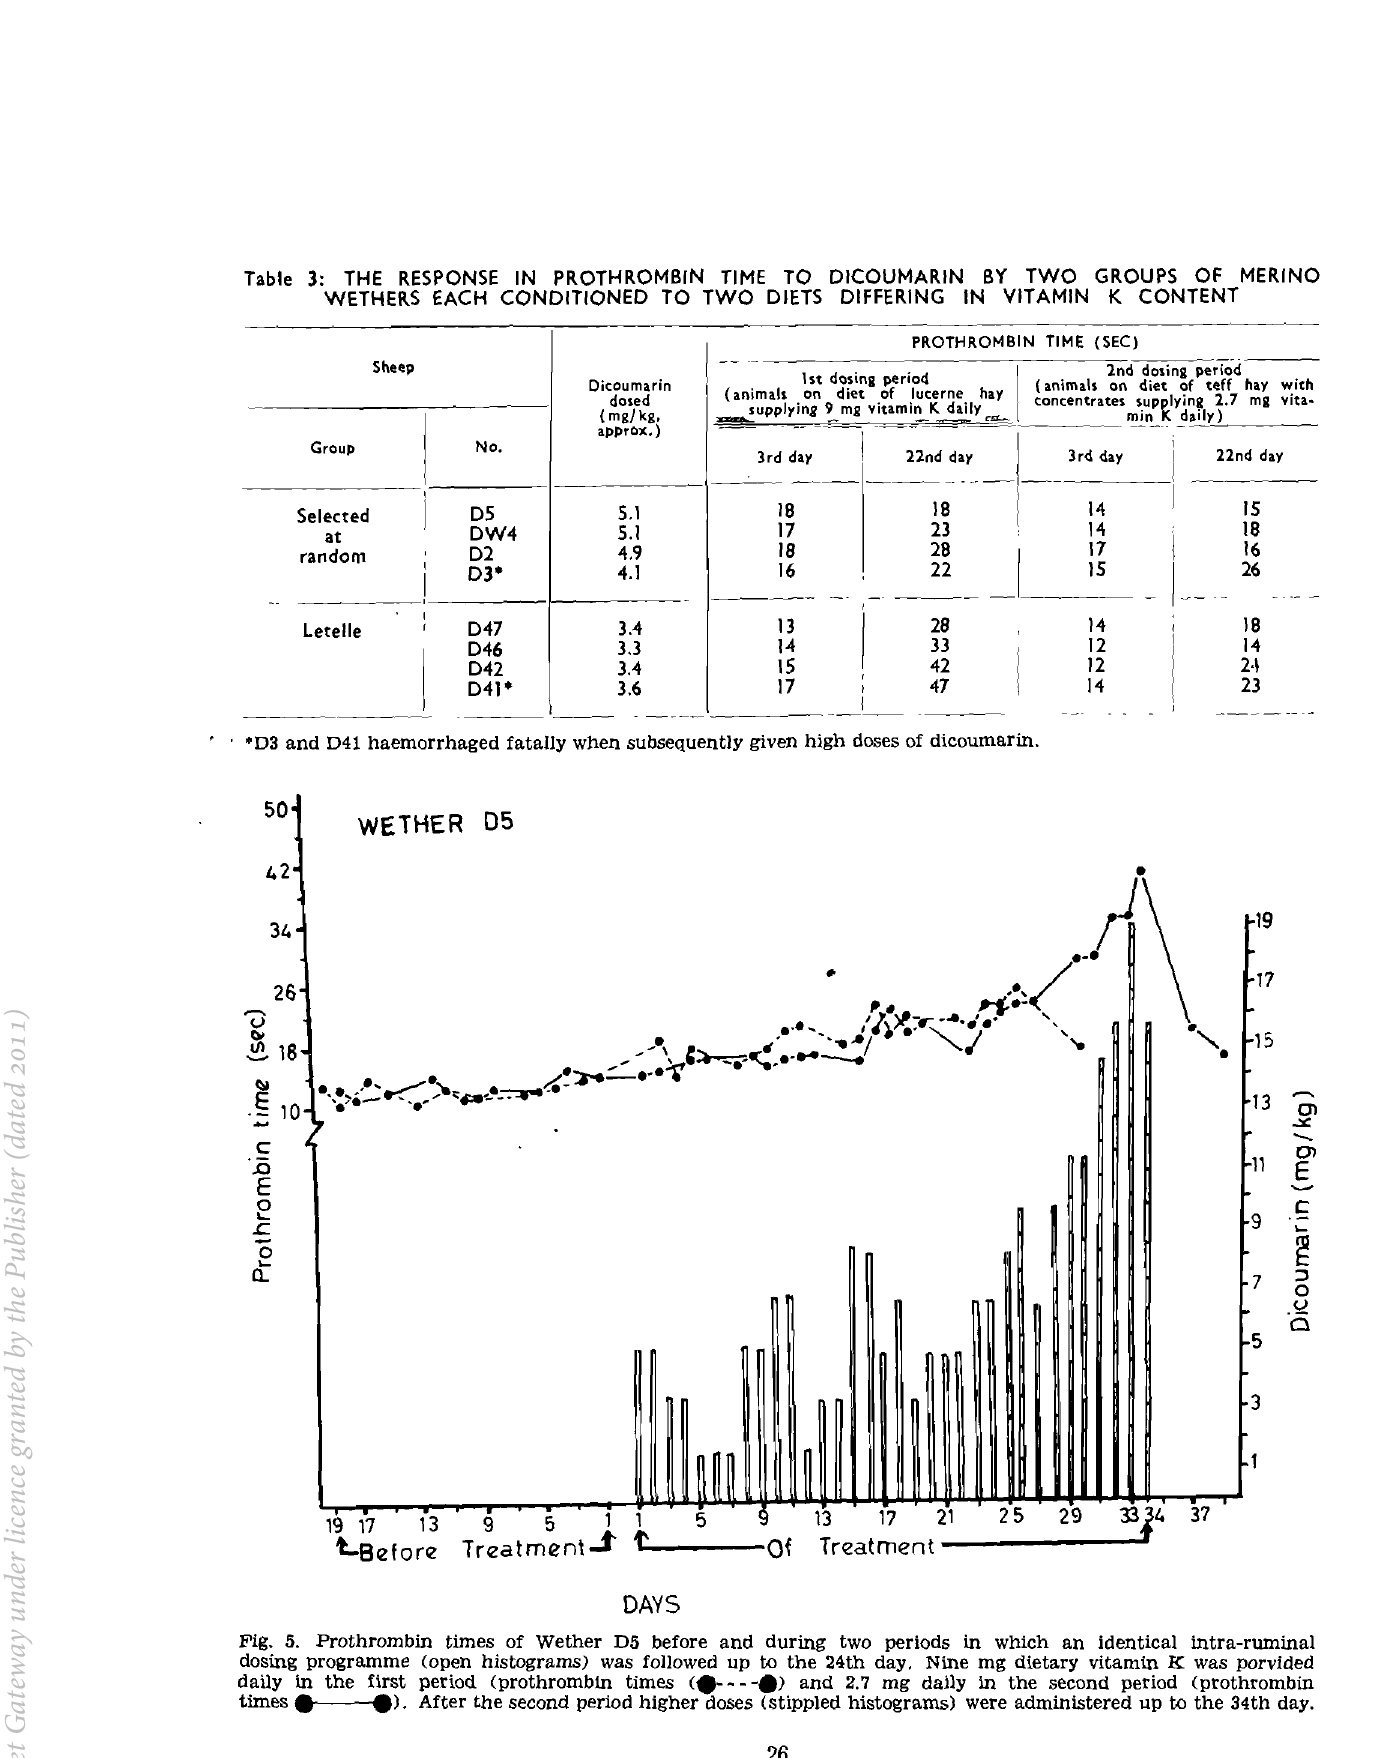
Table 3: THE RESPONSE IN PROTHROMBIN TIME TO DICOUMARIN BY TWO GROUPS OF MERINO WETHERS EACH CONDITIONED TO TWO DIETS DIFFERING IN VITAMIN K CONTENT PROTHROMBIN TIME (SEC) -- -- ~--- Sheep 2nd do,ing period 1st dosing perio<l Dicoumarin (animals on diet of teff hay with do,ed (animal' on diet of lucerne hay